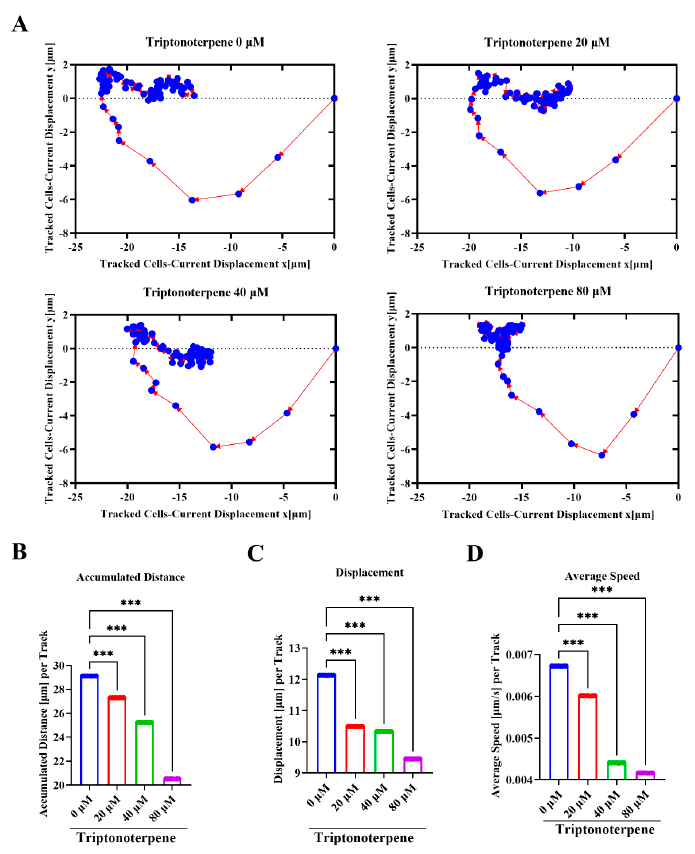
Figure 6. The movement tracks and speed of the GC cells were examined using high − intensity im ‐ aging technology. ( A ) Locus of GC cells 12 h after the Triptonoterpene treatment. ( B ) Total move ‐ ment distance of the GC cells in 12 h. ( C ) Average displacement of the GC cells in different drug groups. ( D ) Average movement speed of the GC cells in different drug groups within 12 h. *** p < 0.001.